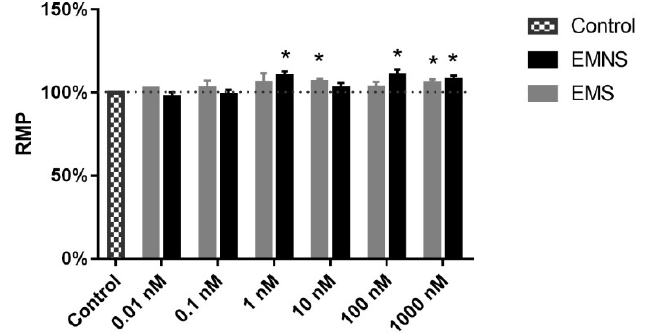
Figure 3. Effect of melatonin on the resting membrane potential (RMP) of N inf excitability melatonin sensitive (EMS) and excitability melatonin not sensitive (EMNS) cells. These data, expressed in normalized values, are presented as means ± SEM and RMP absolute control values are found in Table 1. The number of experiments of N inf EMS neurons at concentrations of 0.01, 0.1, 1.0, 10.0, 100.0, and 1000.0 nM were 1, 4, 6, 10, 3, and, 10, respectively. The number of experiments of N inf EMNS neurons at concentrations of 0.01, 0.1, 1.0, 10.0, 100.0, and 1000.0 nM were 13, 7, 12, 15, 10, and 18, respectively. The symbol * indicates statistically significant difference as compared to control ( p < 0.05, paired Student’s t -test).